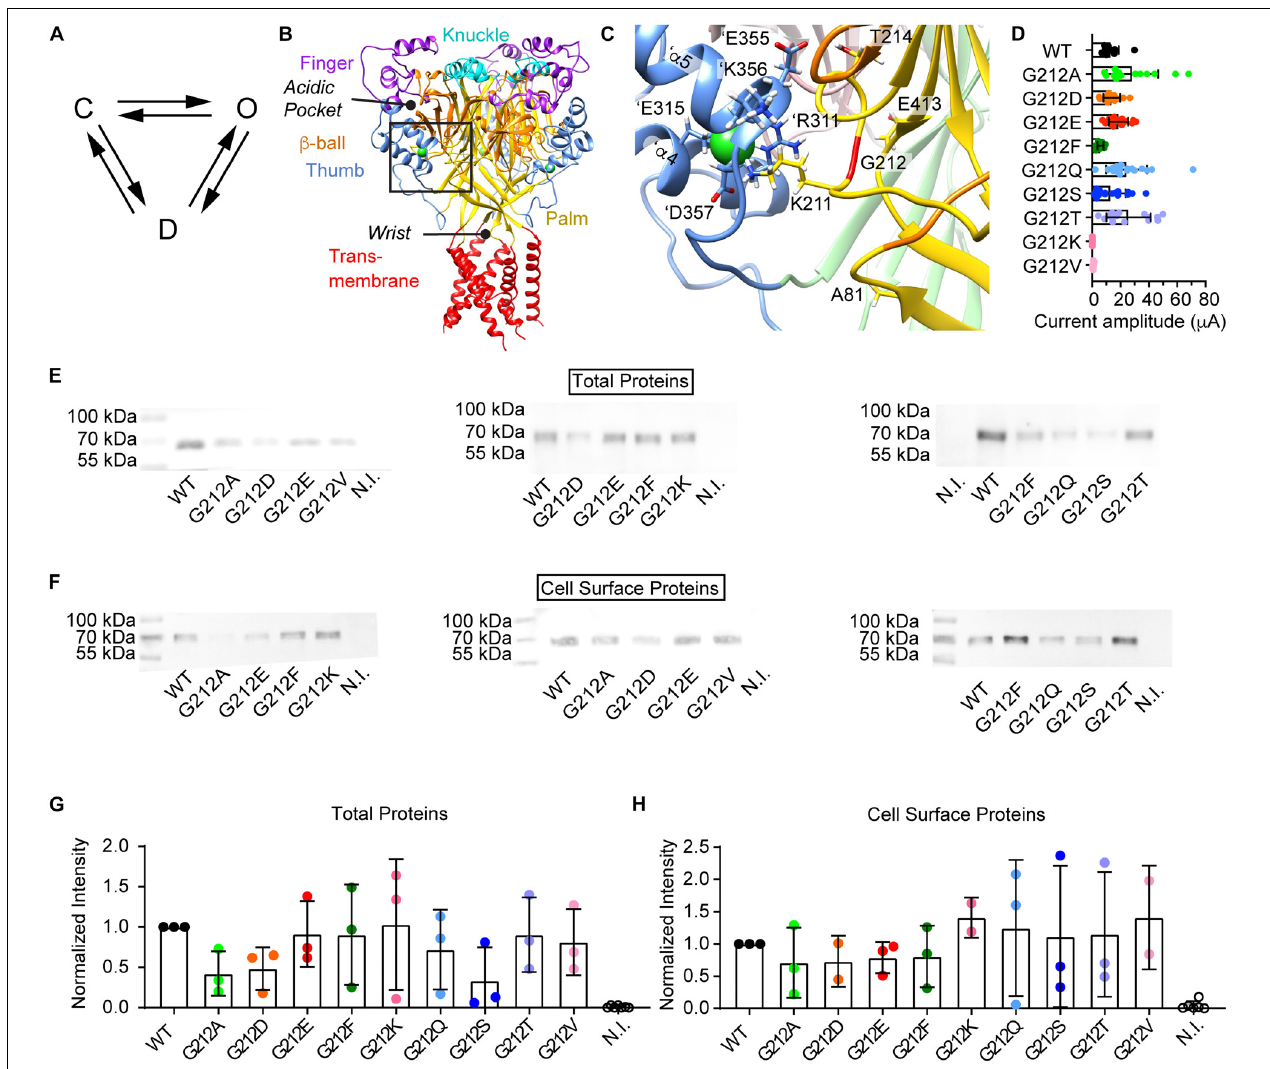
FIGURE 1 | Current and protein expression of Gly212 mutants. (A) Kinetic scheme of ASIC1a activity; C, closed state; O, open state; D, desensitized state. (B–C) The structural images were obtained from a model of human ASIC1a based on the crystal structure of MitTx-opened chicken ASIC1a (4NTW, Baconguis et al., 2014). (B) Trimeric ASIC1a, with domains colored as indicated. The position of the acidic pocket and the wrist are highlighted. The predicted positions of the Cl - ions are indicated by green spheres. The black frame indicates the area of the zoom shown in (C) . (C) Environment of Gly212, with indication of important residues. Gly212 is marked in red. The same color code as in (B) is used, except for the β -ball and palm of the subunit adjacent to the one of which Gly212 is shown. In this neighboring subunit, the β -ball is pink, and the palm is light green. Residue labels of the neighboring subunit are preceded by the prefix ’. (D) Dot-plot of maximal current amplitudes of WT and the Gly212 mutants. Conditioning pH7.4 (7.8 for G212F) was applied for 1 min followed by a 10 s stimulation step to pH pH4.5 for the WT and the mutants G212A, -D, -E -F, -Q, -S and -T, and pH4.0 for the mutants G212K and -V ( n = 7–21). For electrophysiology experiments, Xenopus laevis oocytes were injected with 1–44 ng RNA per oocyte (WT: 2.5, G212D:1, G212E: 5, G212T: 5, G212V, -A, and -Q: 24, G212K: 32 and G212F: 44 ng). (E–H) For the biochemistry analysis, the same amount of cRNA, 10 ng per oocyte, was injected for all mutants. (E) Western blot of total proteins. Anti-ASIC1 antibody was used to detect the proteins. (F) Western blot images of biotinylated cell surface proteins. Anti-ASIC1 antibody was used to detect the proteins. (G) Total protein quantification. Gel background intensity is subtracted from the band intensity and values are normalized to the WT signal on the same blot. (H) Biotinylated surface protein quantification. Gel background intensity is subtracted from the band intensity and values are normalized to the WT. N.I.,